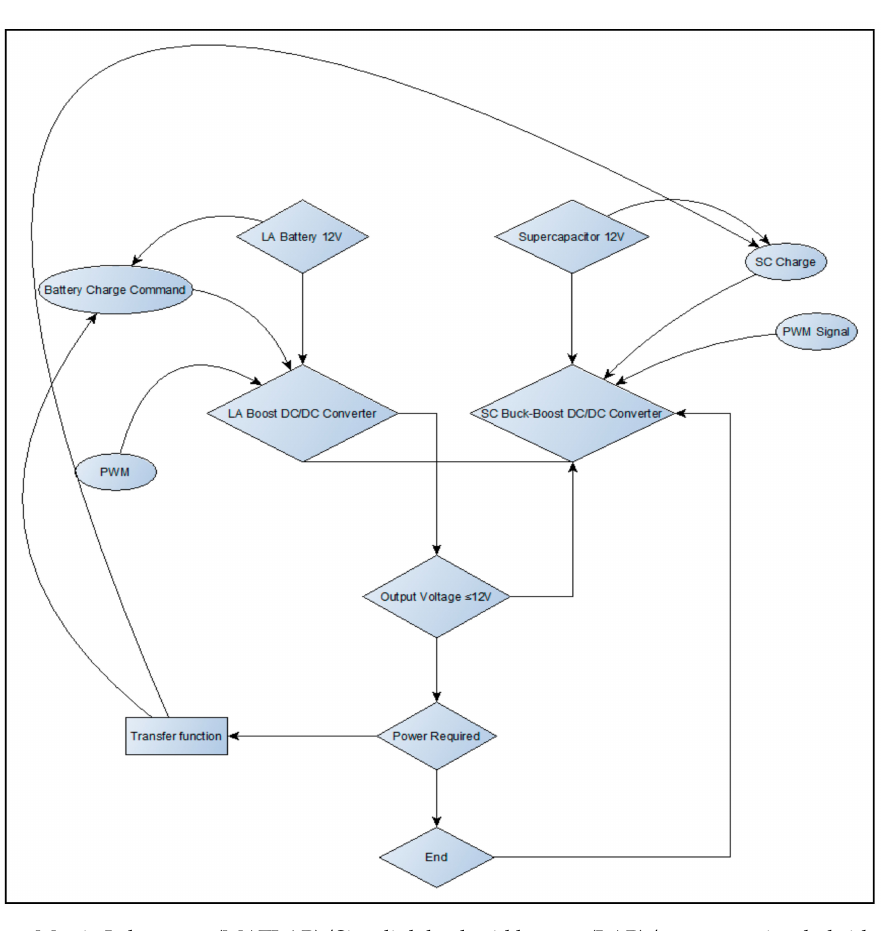
Figure 1. Matrix Laboratory (MATLAB)/Simulink lead acid battery (LAB)/supercapacitor hybrid system based on two direct current-to-direct current (DC/DC) converters. PWM—power width